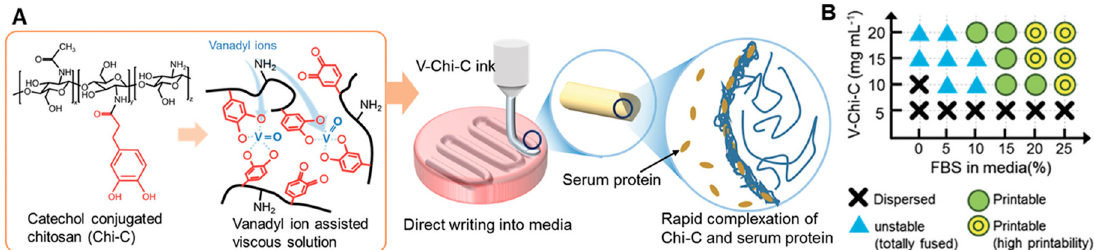
Figure 10. Catechol-chitosan ink with vanadyl ions (V-Chi-C). ( A ) Preparation of the ink and 3D printing process. ( B ) The printable window using the combination of V-Chi-C solution prepared as a function of concentration and the culture media containing fetal bovine serum (5, 10, 15, 20 or 25%). Reproduced from [129] with permission from The Royal Society of